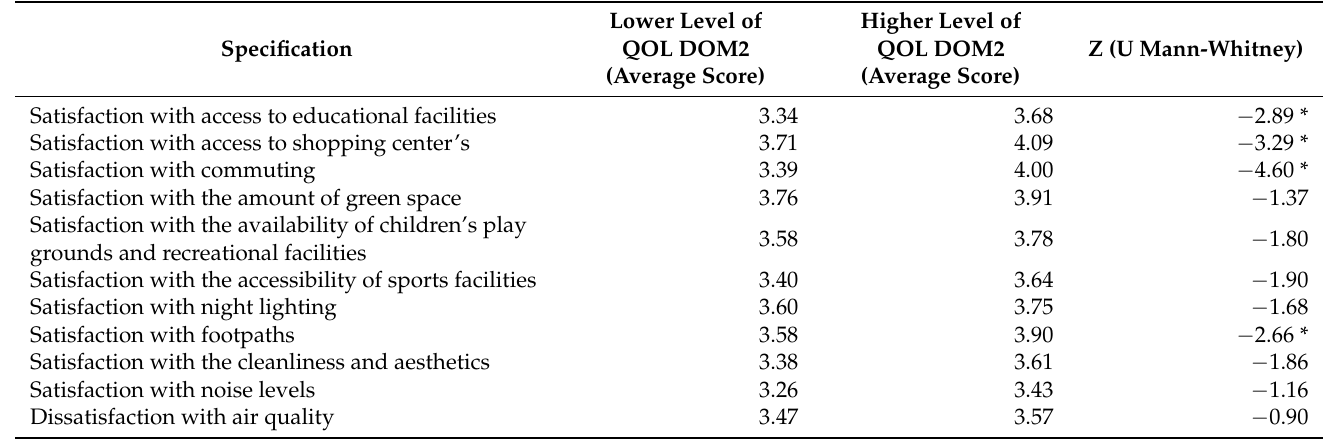
Table 4. Level of satisfaction with selected elements of urban infrastructure concerning the level of quality of life in the psychological domain (DOM2) (Mann-Whitney U test).